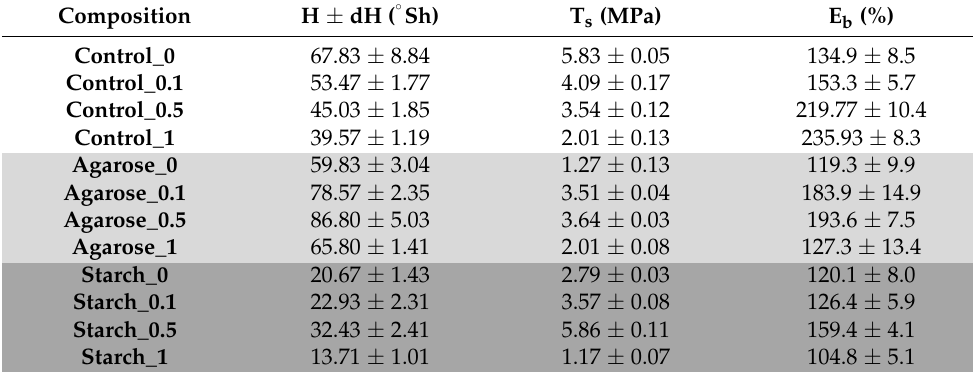
Table 1. Shore A hardness measurements with standard deviation.